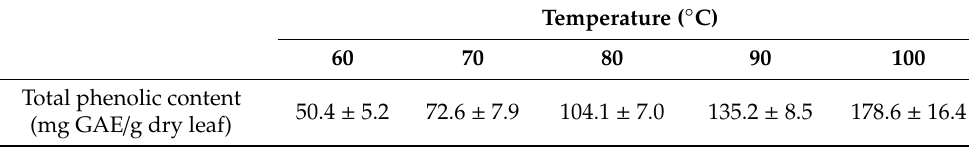
Figure 5. Correlation between DPPH IC 50 and total phenolic content. Table 1. E ff ects of temperature on the total phenolic content of black